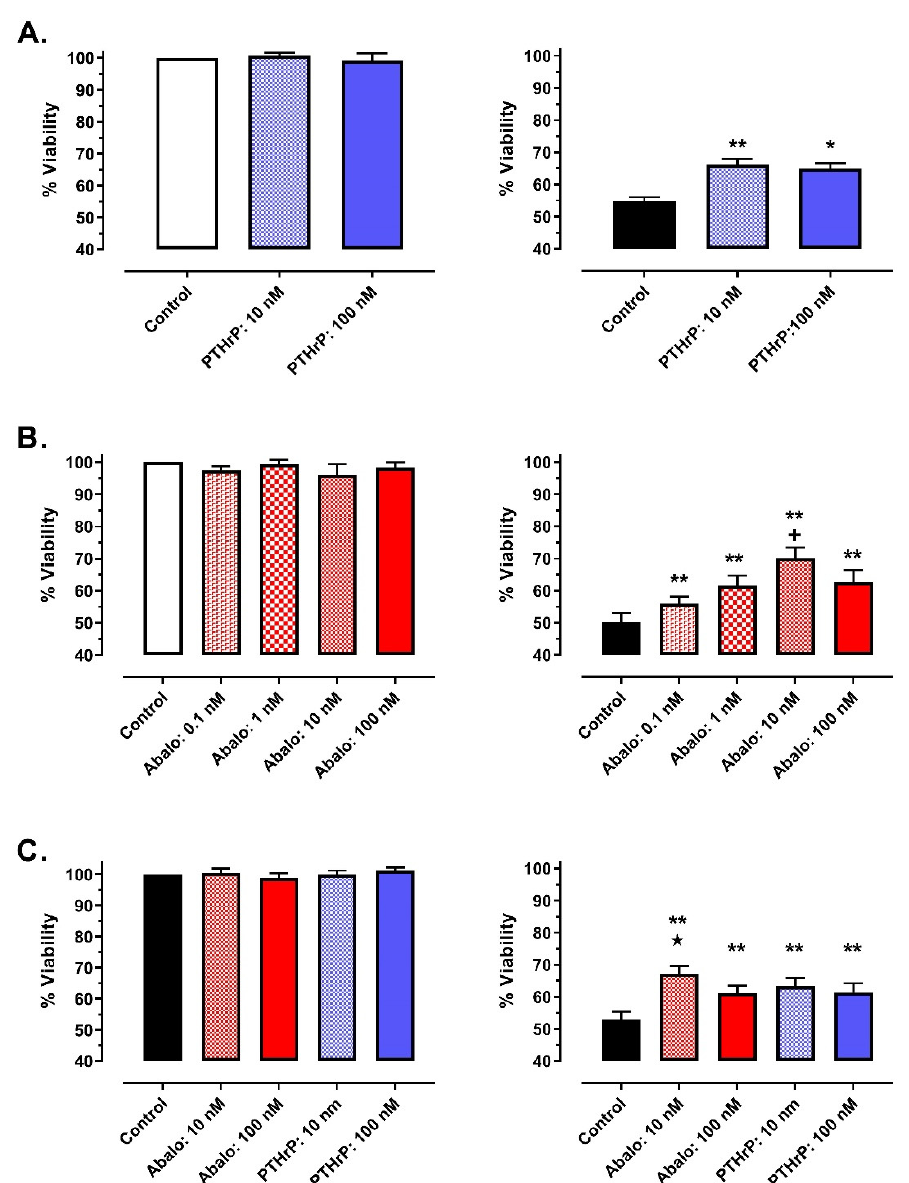
Figure 1. Effect of PTHrP(1-36) (PTHrP: Panel A ), abaloparatide (Abalo: Panel B ) and concurrent assessment of PTHrP(1-36) and Abalo ( Panel C ) on viability of HL-1 cardiomyocytes maintained under normoxic conditions ( left panels ) or subjected to simulated ischemia-reperfusion ( right panels ). Data reported as mean ± SEM. * p < 0.05, ** p < 0.01 versus matched vehicle-control group; + p < 0.05 versus Abalo 0.1 nM, 1 nM and 100 nm; (cid:70) p < 0.05 versus Abalo 100 nM, PTHrP 10 nM and PTHrP 100 nM.